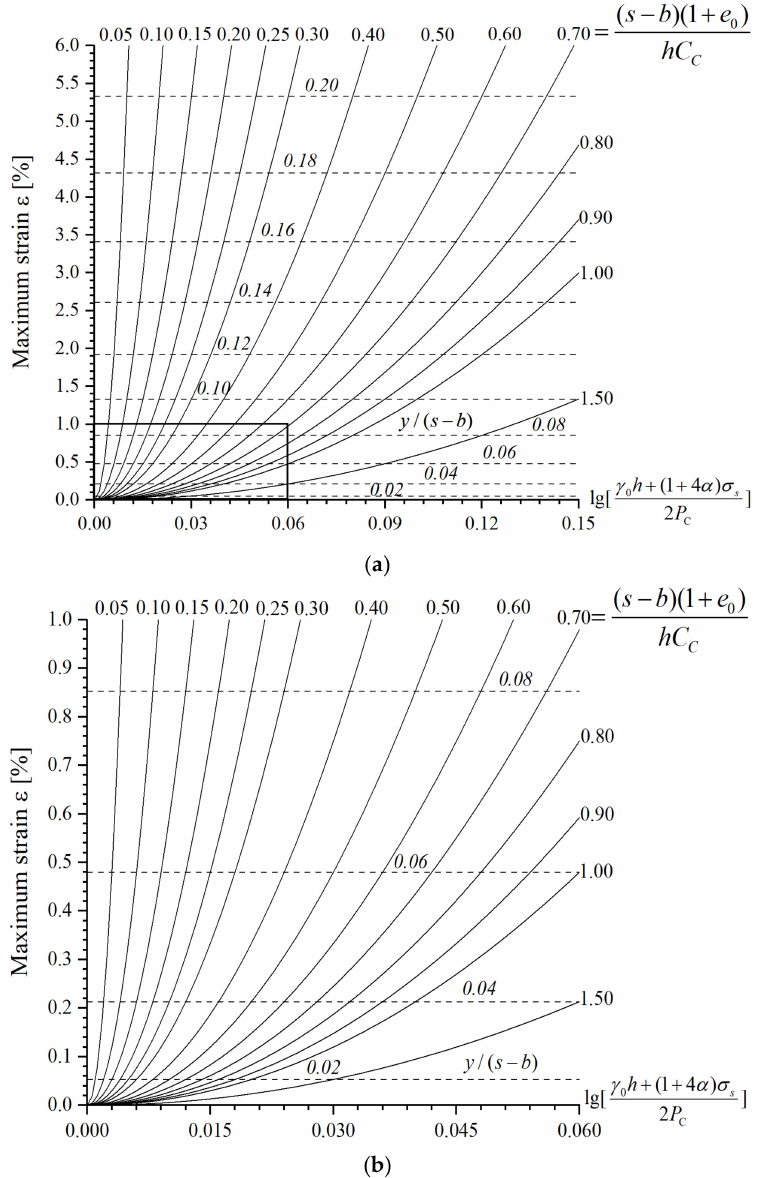
Figure 6. Design charts for a GRPE with under-consolidated soil; ( a ) Full-scale chart; ( b ) Enlarged